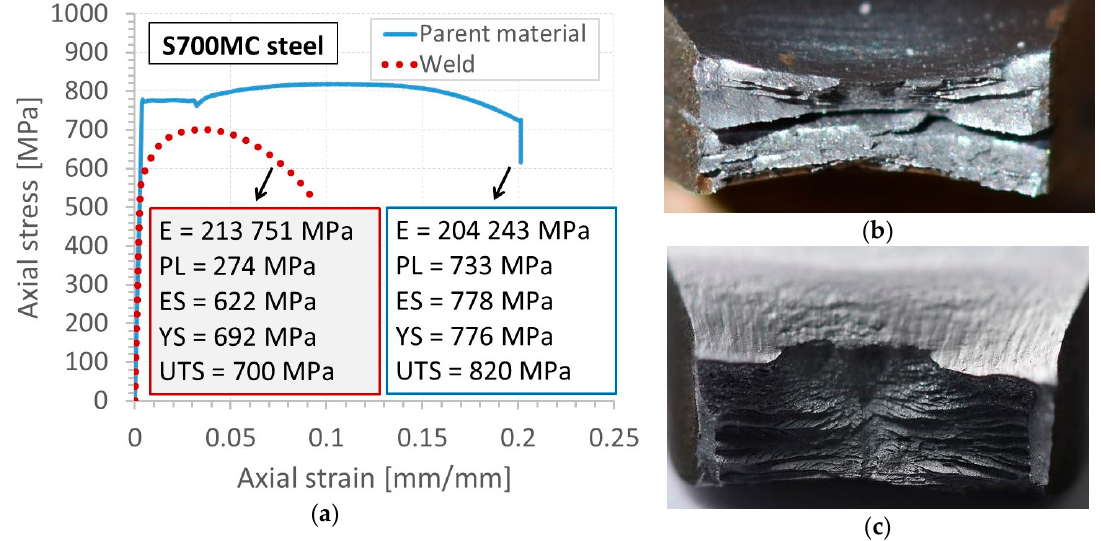
Figure 4. Tensile characteristics of the S700MC steel and its weld ( a ), with the fracture regions of the parent material ( b ), and the zone close to the weld ( c ).